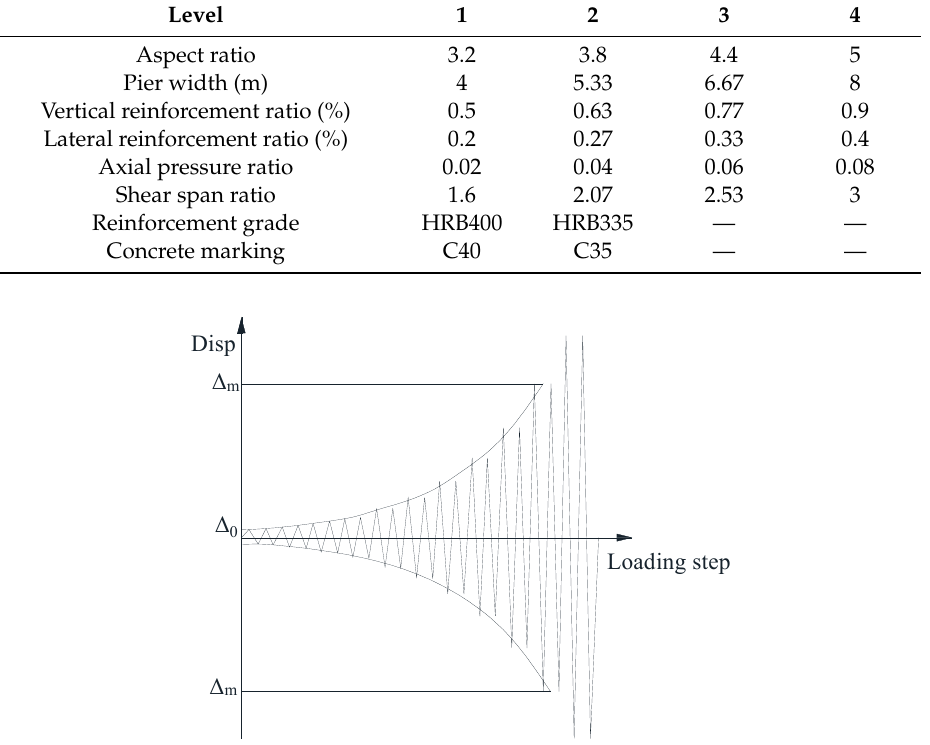
Table 4. Factor levels of wall pier.